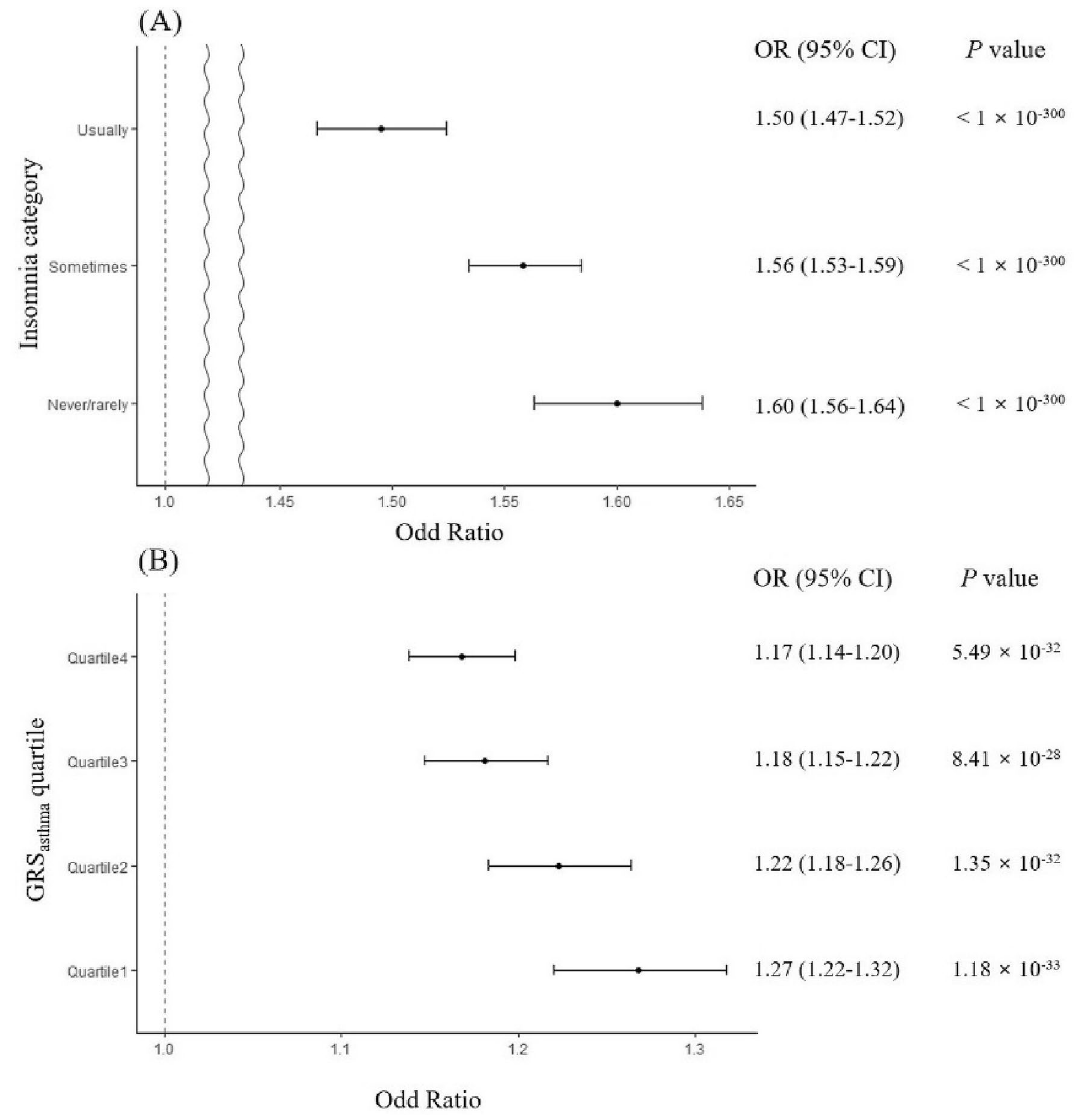
Figure 2. Effect of GRS asthma and insomnia on asthma on the basis of insomnia categories and GRS asthma quartiles. The odds ratio (OR) of asthma is plotted as dots ± 95% confidence interval. ( A ) The association between asthma and GRS asthma by insomnia categories by considering age, age 2 , sex, batch size, and 10 principle components. The GRS asthma is scaled to mean = 0 and standard deviation = 1 to facilitate interpretation. ( B ) The variation in OR for asthma on insomnia by GRS asthma quartiles after considering age and